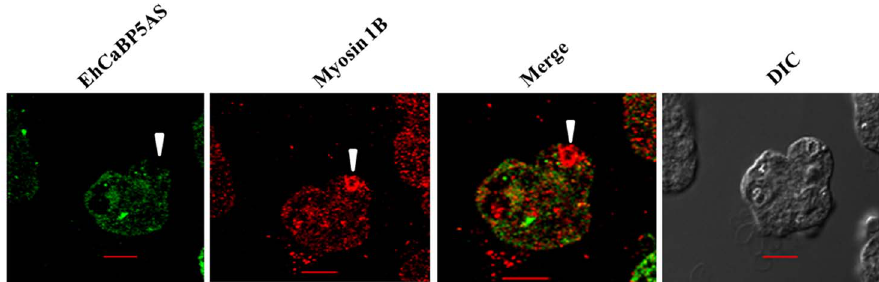
Fig 9. Erythrophagocytosis of amoebic cells overexpressing EhCaBP5 antisense RNA in presence of tetracycline. Amoebic cells were incubated with RBC for 15 min. The cells were then stained with Alexa 488 (EhCaBP5) and myosin 1B (red). Solid arrow heads represent the closure of phagocytic cup. (scale bar, 10 m m; DIC, differential interference contrast).